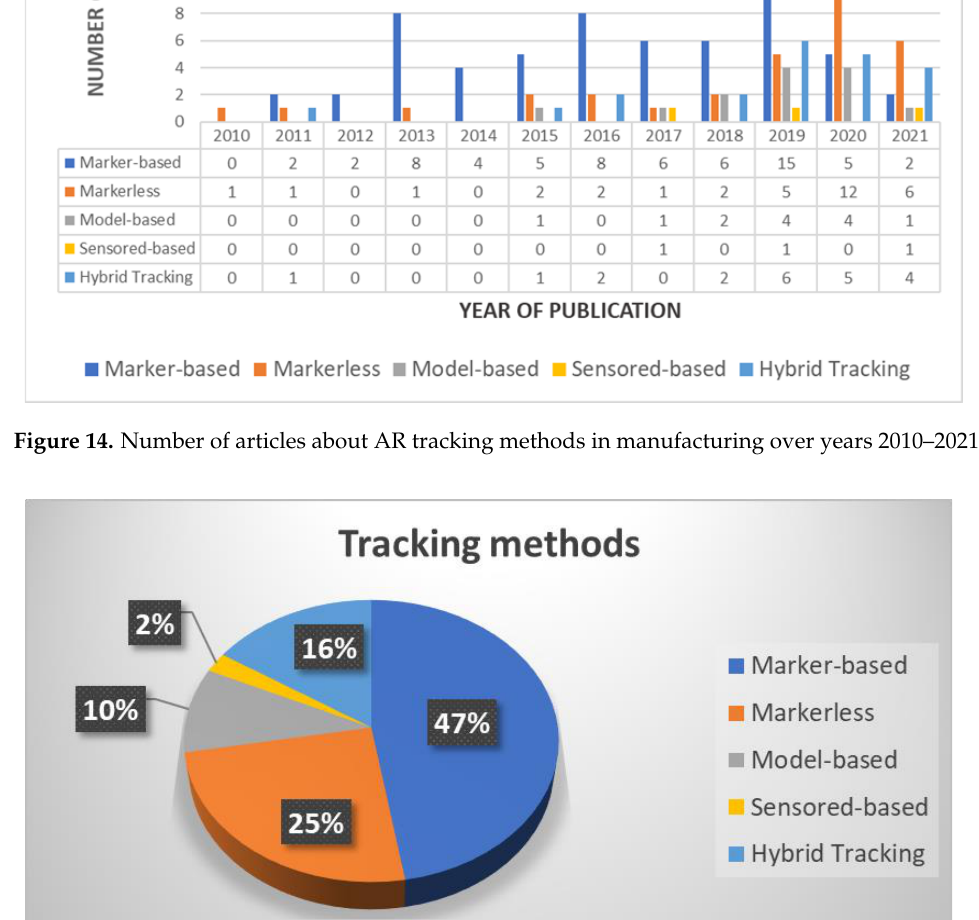
Figure 15. Distribution of tracking methods in terms of tracking methods from 2010 – 2021.